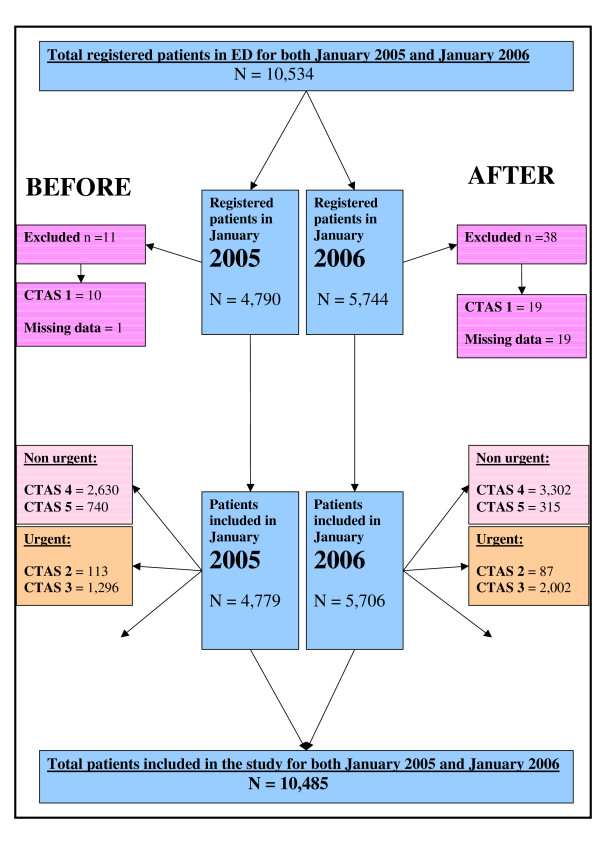
A schematic summary of the number and disposition of study participants.